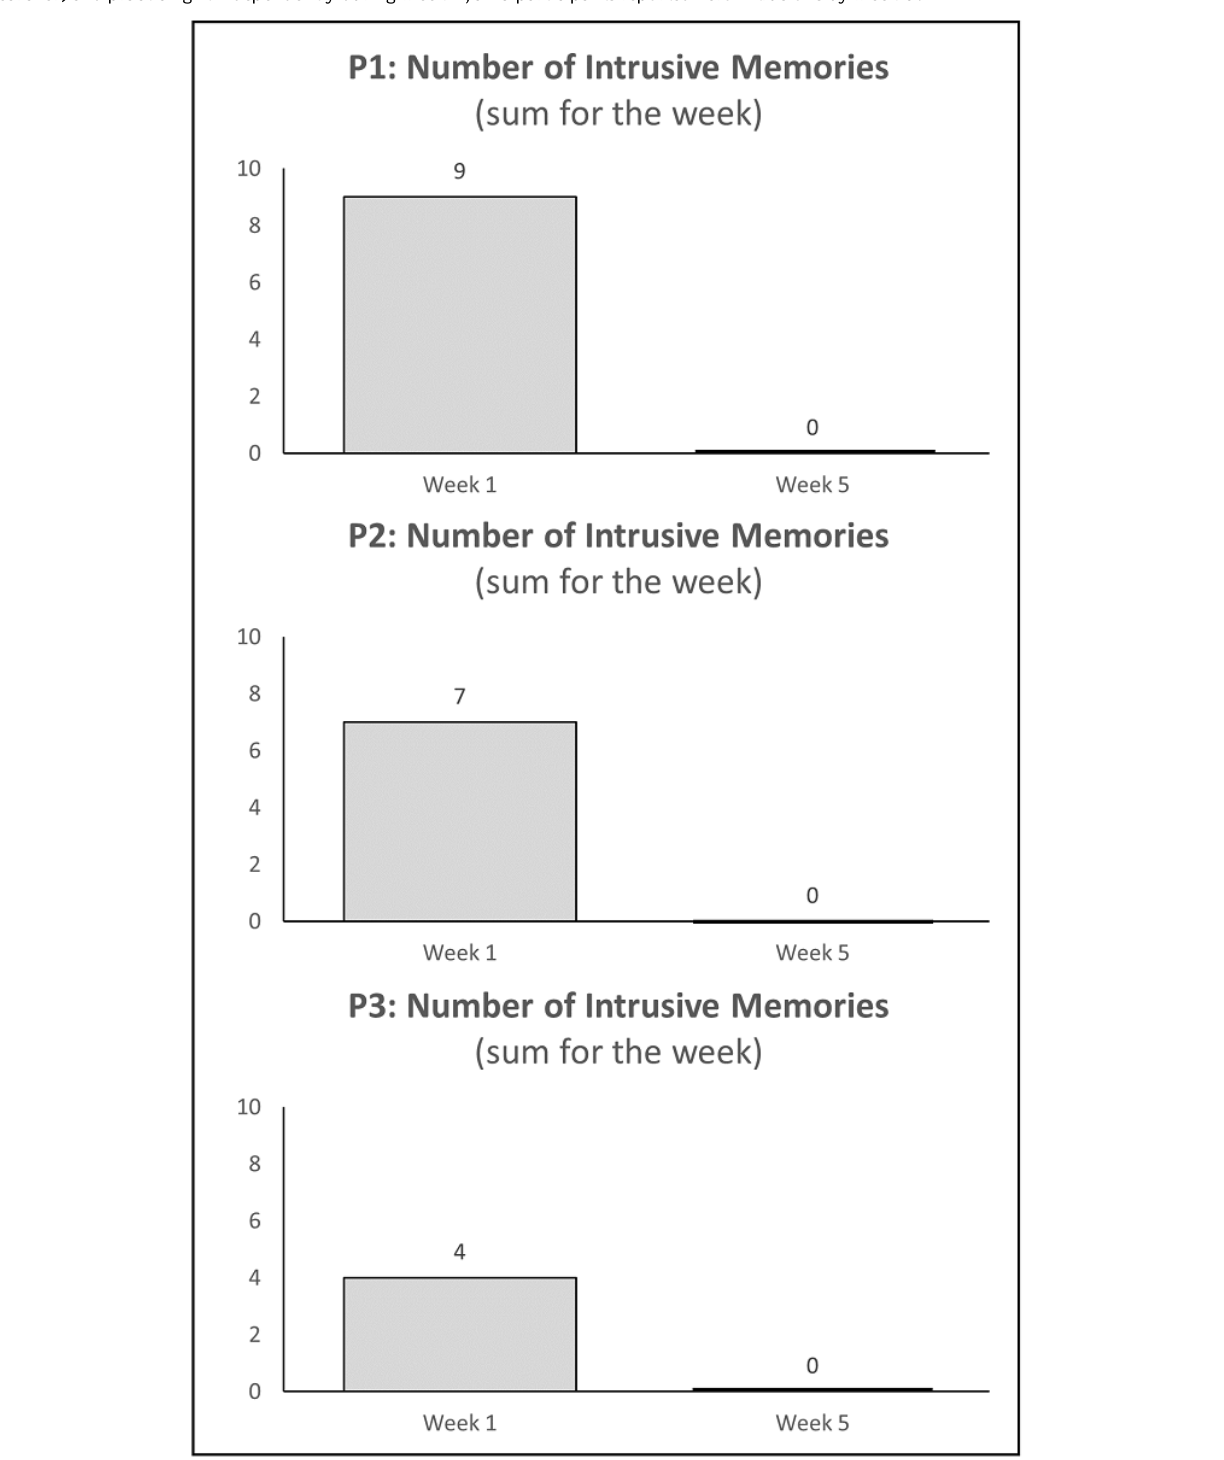
Figure 2. Graphs for visual inspection of the number of intrusive memories of trauma (sum for the week) during week 1 (secondary outcome) and week 5 (primary outcome) following the initial intervention session for each participant. After learning how to do the intervention (guided by the researcher) and practicing it independently during week 1, all 3 participants reported zero intrusions by week 5.